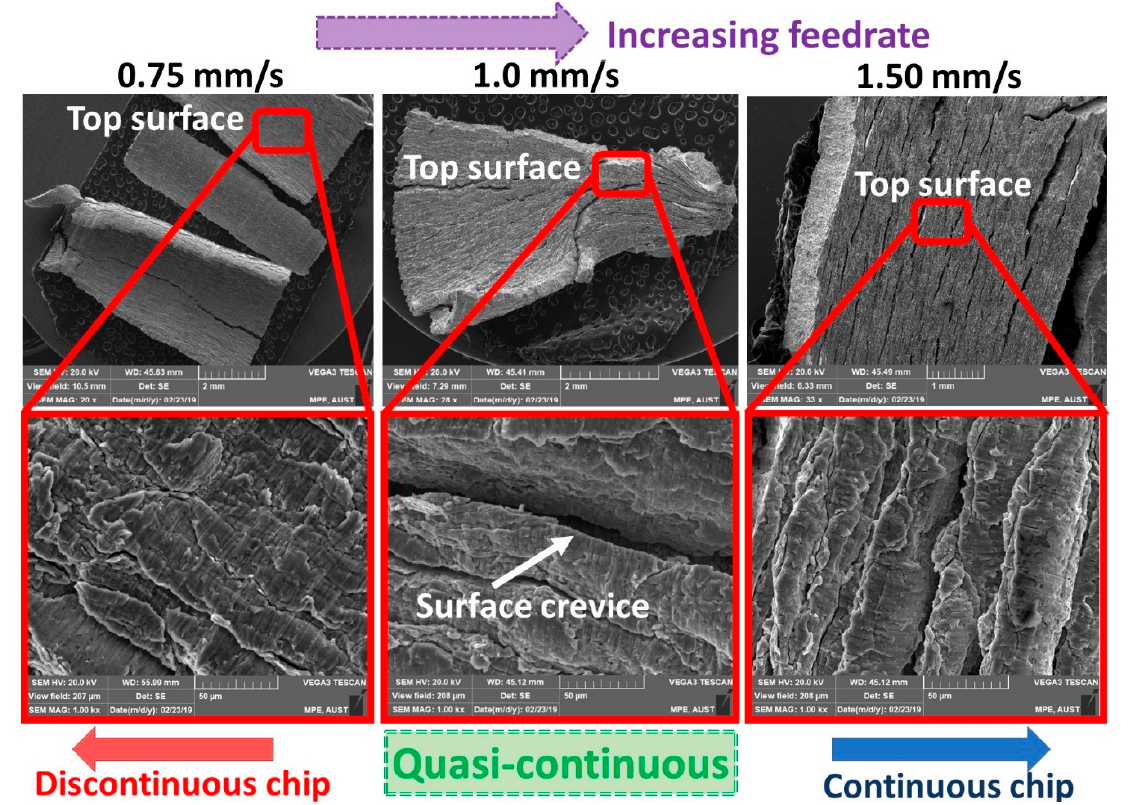
Figure 9. SEM image analysis of the top (free) surface of Al alloy macro chips.